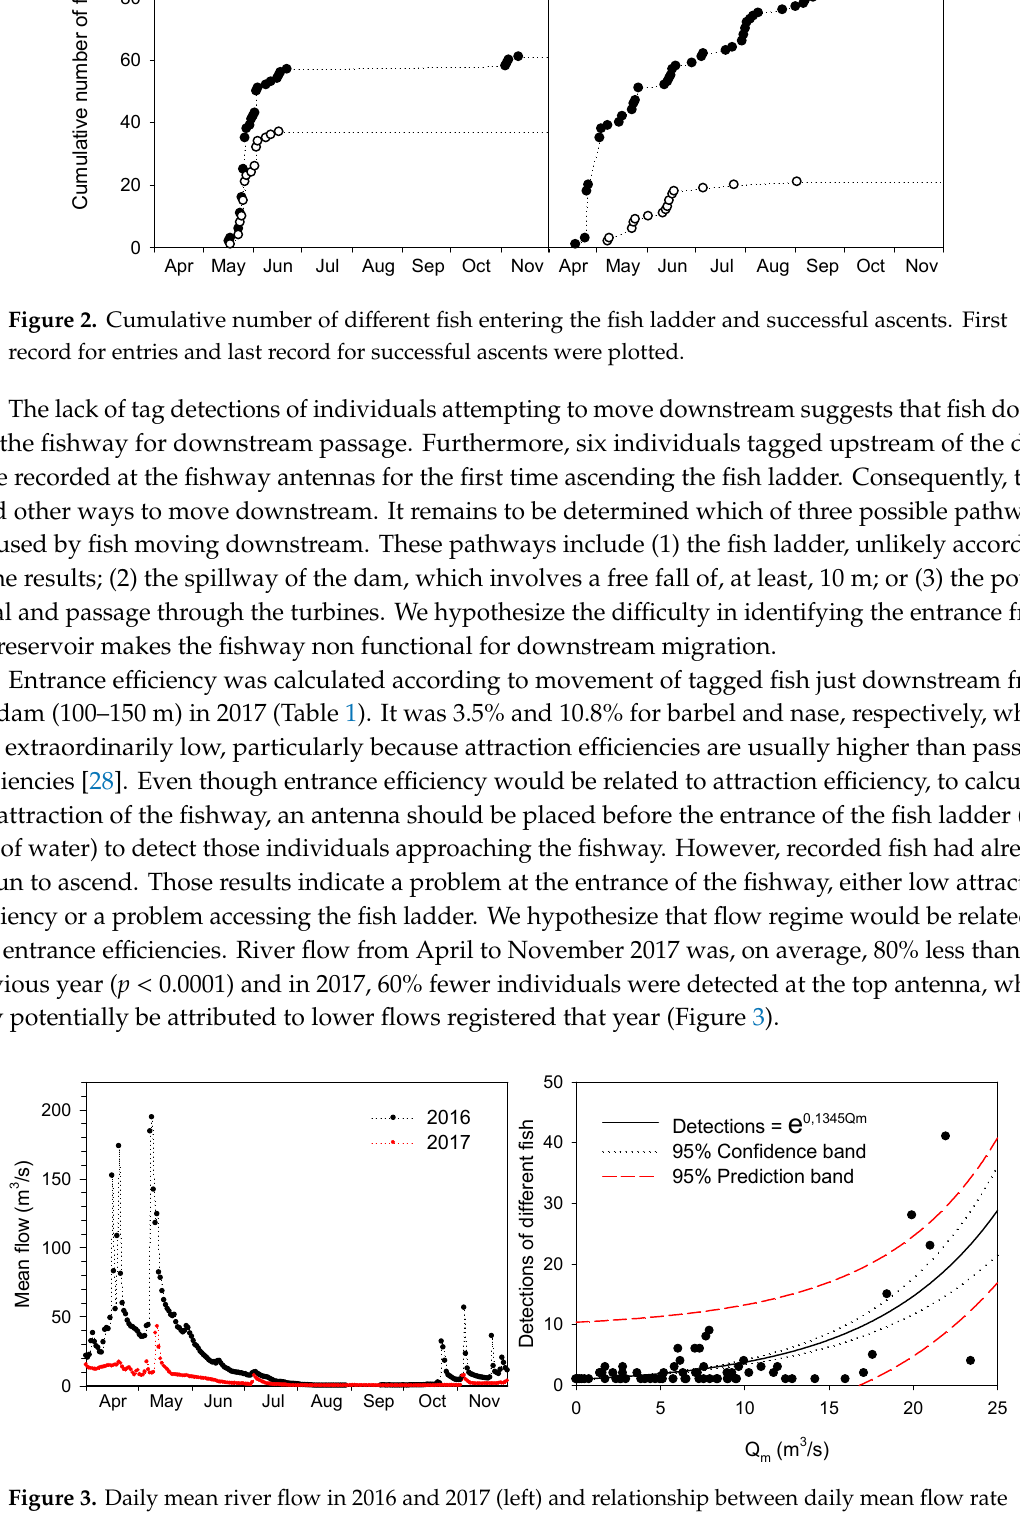
Figure 3. Daily mean river flow in 2016 and 2017 (left) and relationship between daily mean flow rate and top antenna detections (right). Flow was measured in a gauging station 5 km upstream from the dam.